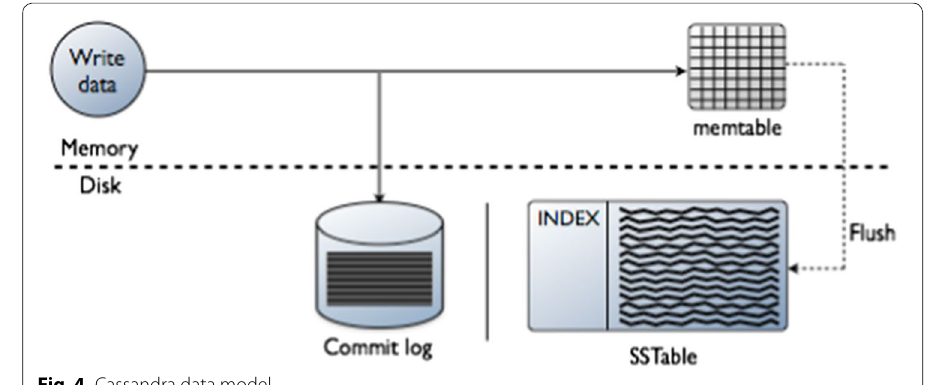
Fig. 4 Cassandra data model